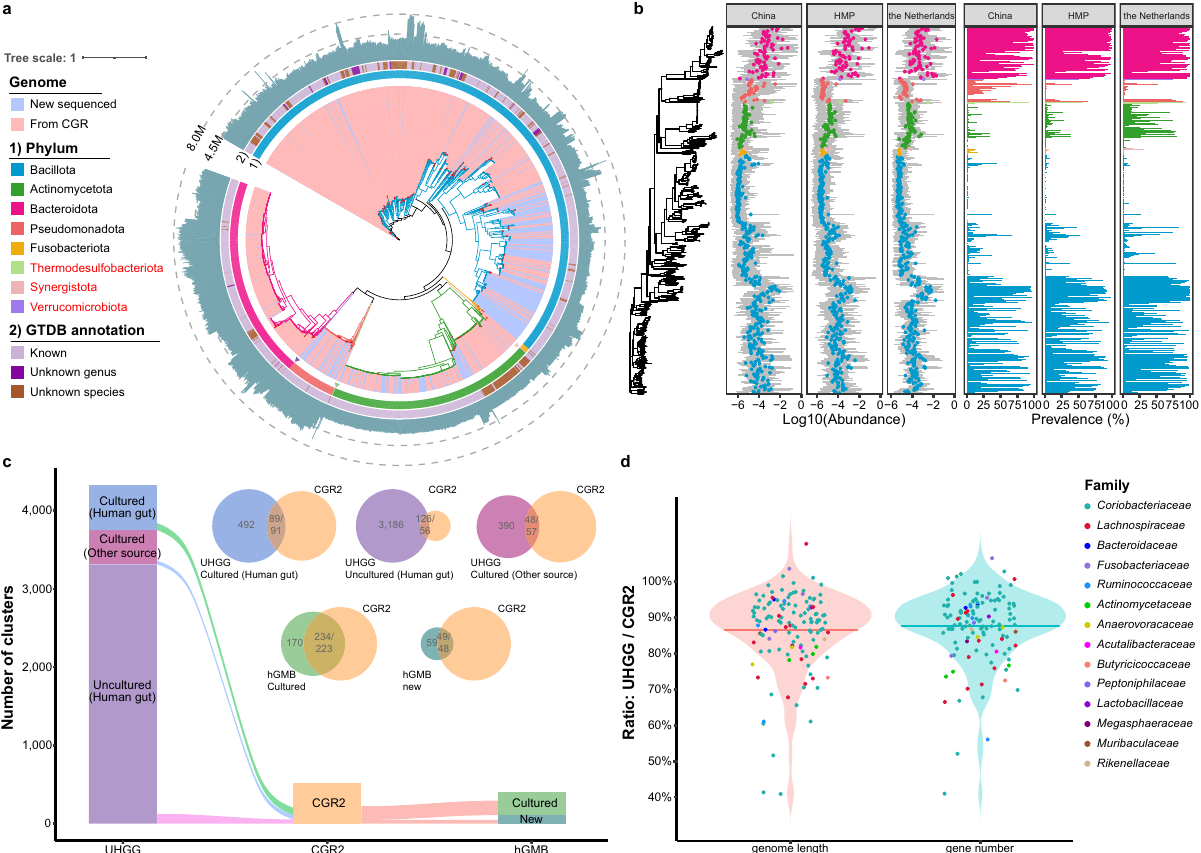
Fig. 1 | Taxonomic pro fi le of CGR2. a Phylogenetic analysis of 3324 genomes. Colorrangeindicatesthe1804newlysequencedgenomes(blue)andthe1520CGR genomes (pink). Singleton genomes are marked with red dots at the end of the clade. The fi rst layer depicts the GTDB phylum annotation, the second layer describes the matching to the GTDB database at the species and genus level, and the circumferential bar plot (dark blue) illustrates the genome size. b Abundance andprevalenceof527representativeclustersinhealthycohortsofChina,HMP,and